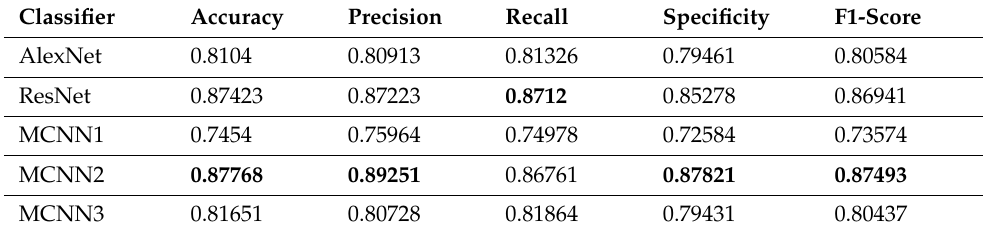
Table 6. Classification results using added synthetic noise to image data.